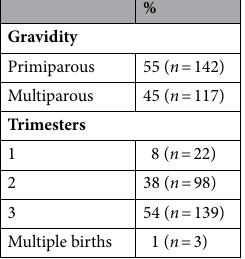
Table 1. Details of pregnancy in pregnant